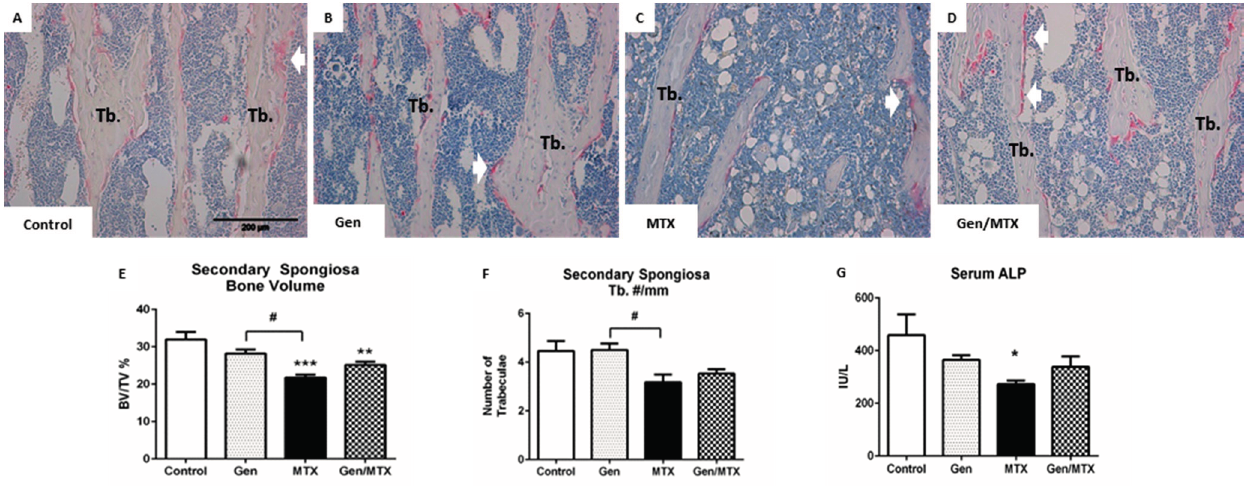
Figure 2. MTX reduced metaphyseal trabecular bone volume and serum levels of alkaline phosphatase (ALP) compared to the control. ( A – D ) Representative images (20×) of haematoxylin and eosin (H&E) and tartrate-resistant alkaline phosphatase (TRAP, a marker for osteoclasts)-stained sections for control, MTX-, genistein (Gen)-, and Gen/MTX-treated groups, respectively. Pink staining indicates osteoclasts (white arrows) which line the trabecular bone (Tb) surface; ( E ) Quantification of bone volume measured as the percentage of total tissue area occupied by trabecular bone (BV/TV%); ( F ) Quantification of the number of trabeculae spanning the width of the secondary spongiosa (Tb.#/mm); ( G ) Serum analysis of ALP levels. * p < 0.05, ** p < 0.01 and *** p < 0.001 vs. control; # represents a